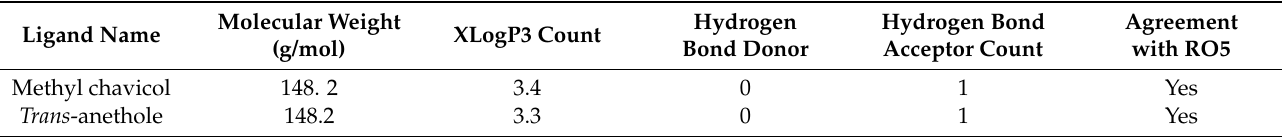
Table 10. Properties of Lipinski’s RO5 associated with methyl chavicol and trans -anethole.